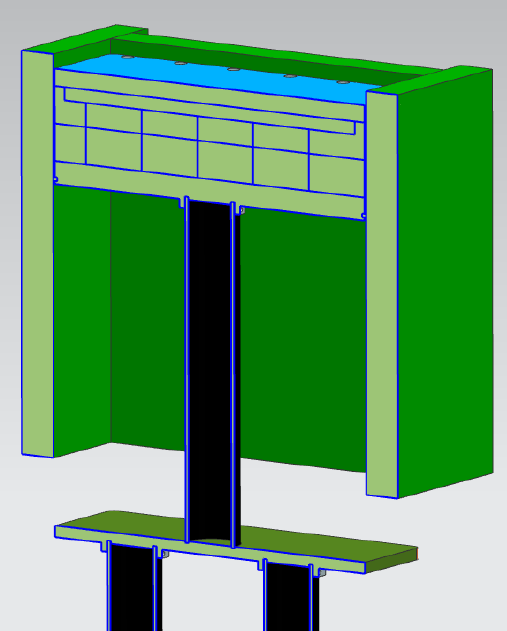
Figure 16. 3D view of HeatGenPro preheating concept.